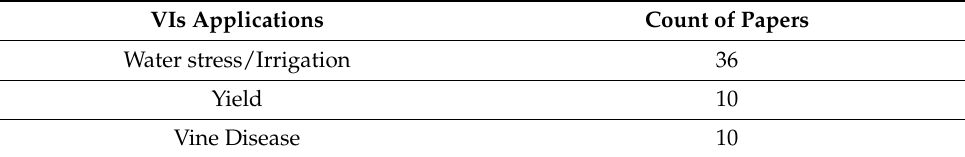
Table 7. Vegetation indices applications on